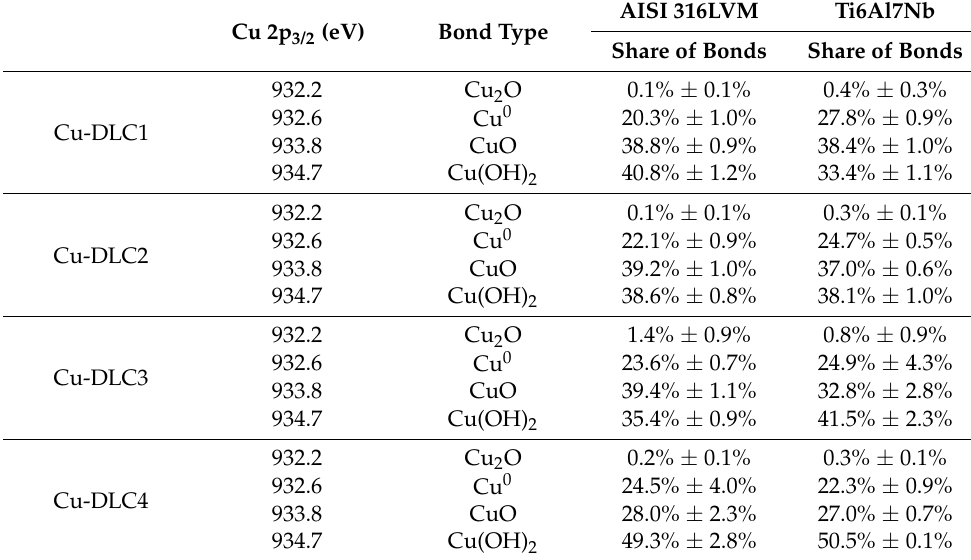
Table 4. Deconvolution of Cu 2p 3/2 peak obtained in the XPS analysis.